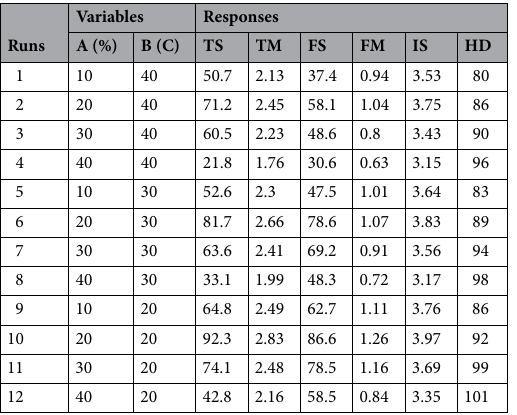
Table 2. Experimental outcomes involved in the statistical analysis.